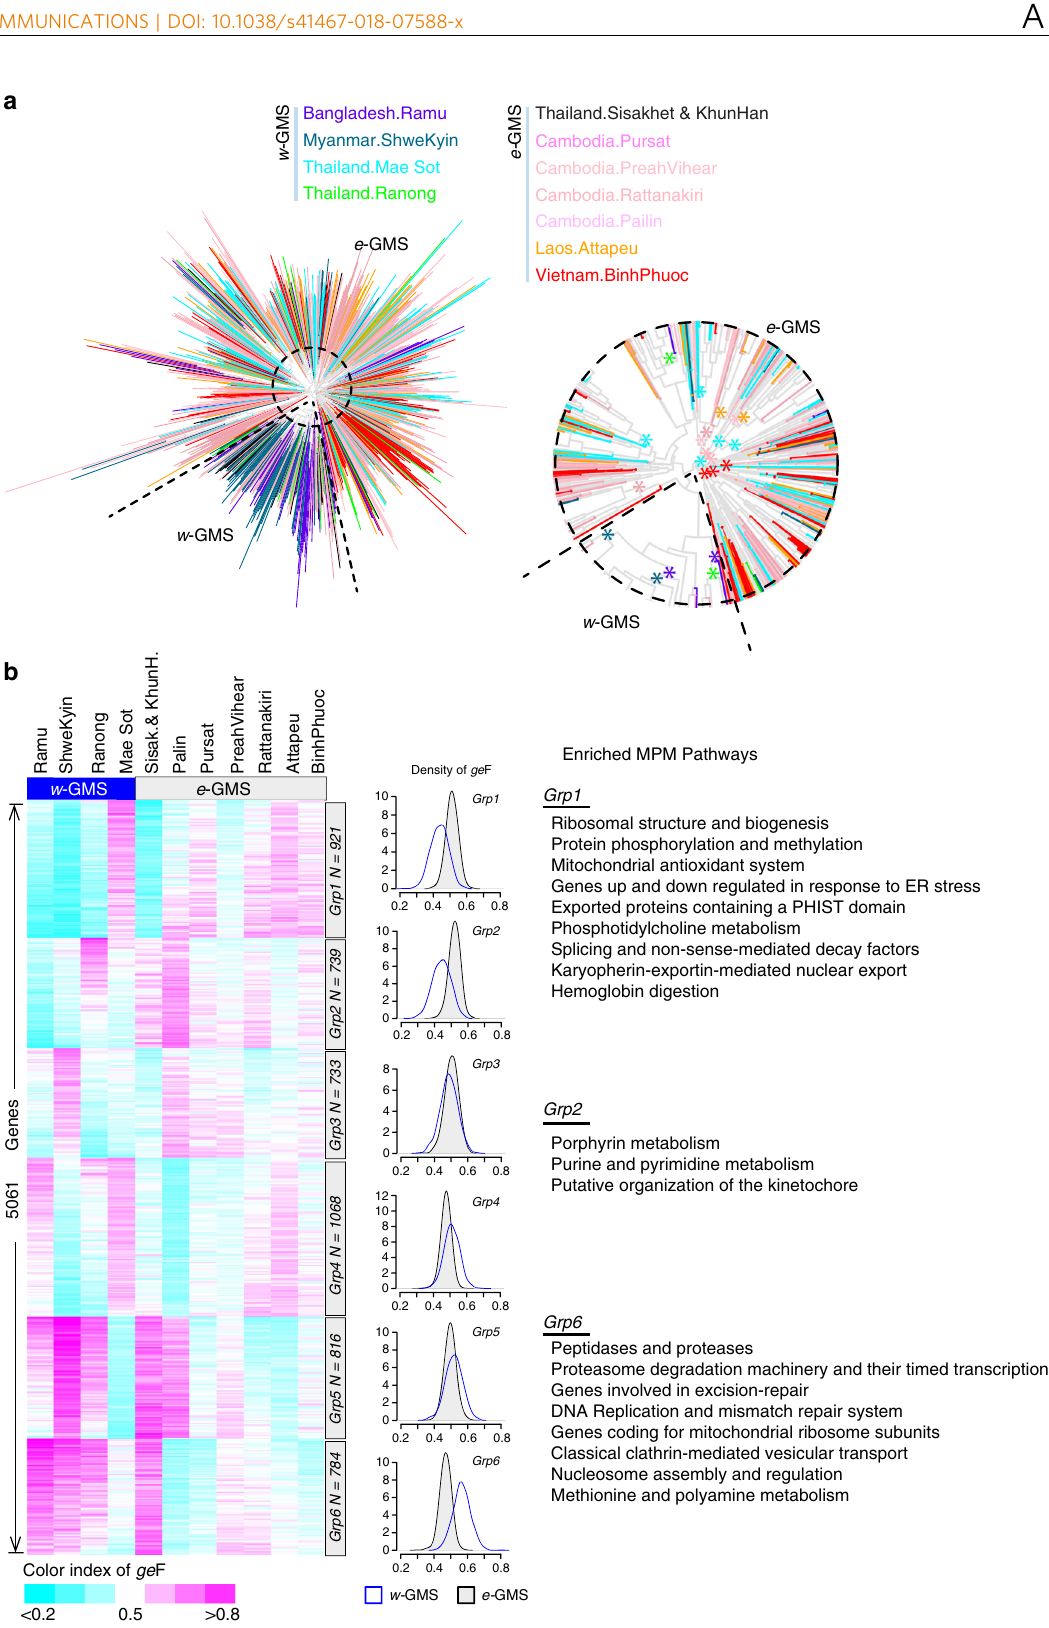
to genes encoding PHIST proteins (PHISTa, PHISTb, PHISTc, RESA, LSAP2), protein kinases and proteins related to protein phosphorylation or traf fi cking ( p -value < 0.05, hypergeometric test). Nonetheless, the identi fi ed eQTL set was dominated by distal linkages. To better capture the potential effects of